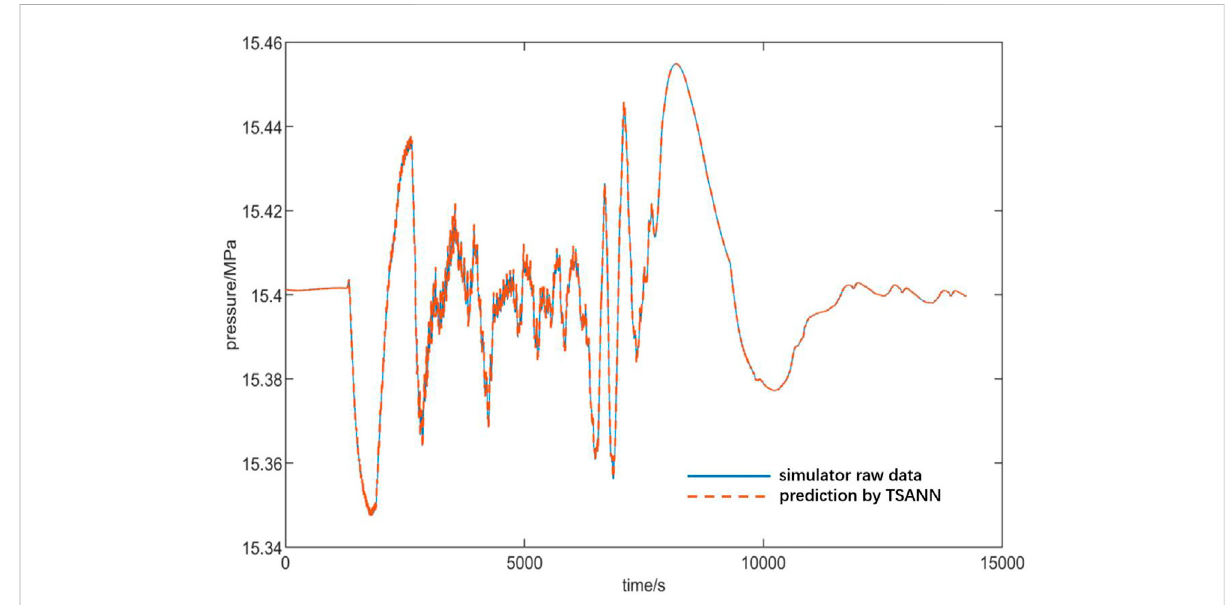
FIGURE 13 Veri fi cation of the generalization ability of the TSANN established for pressure of the primary-circuit